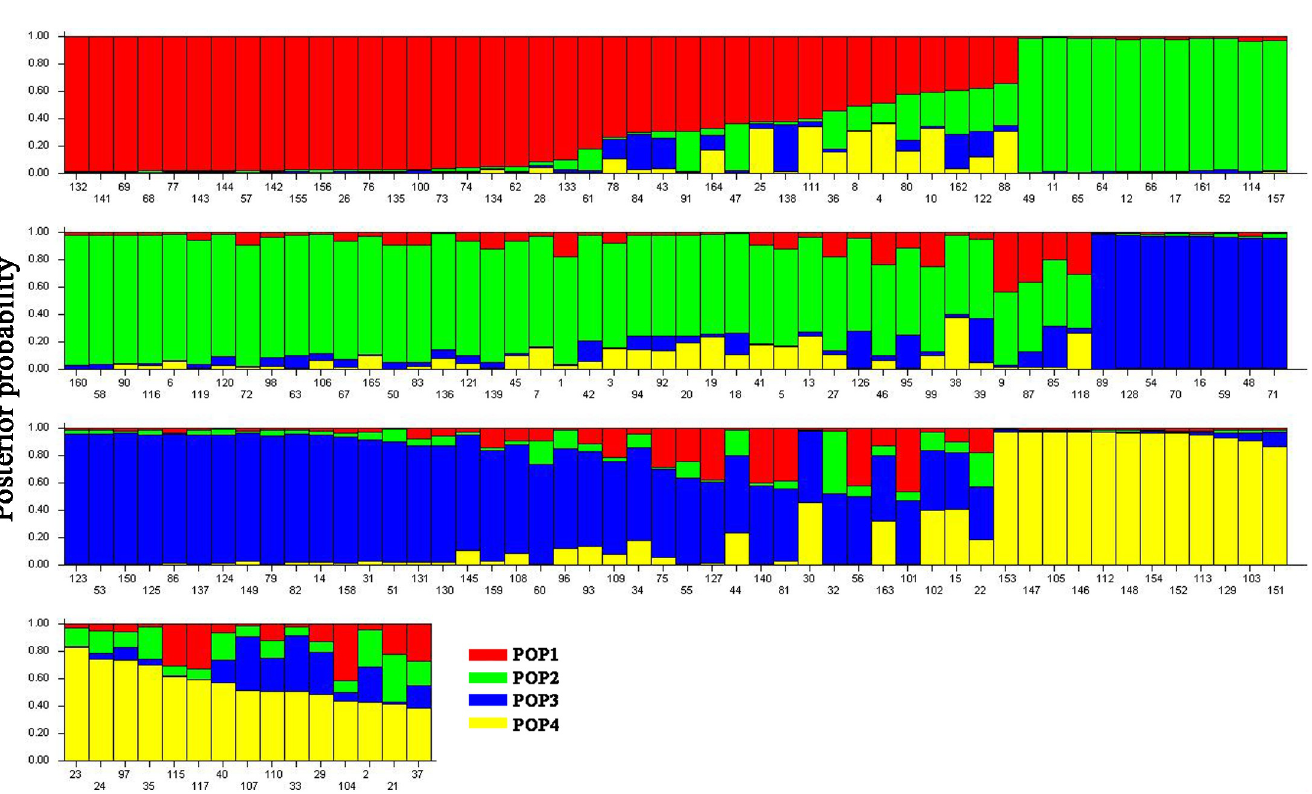
Fig 6. Population structure of the 165 cauliflower inbred lines based on 43 SSR